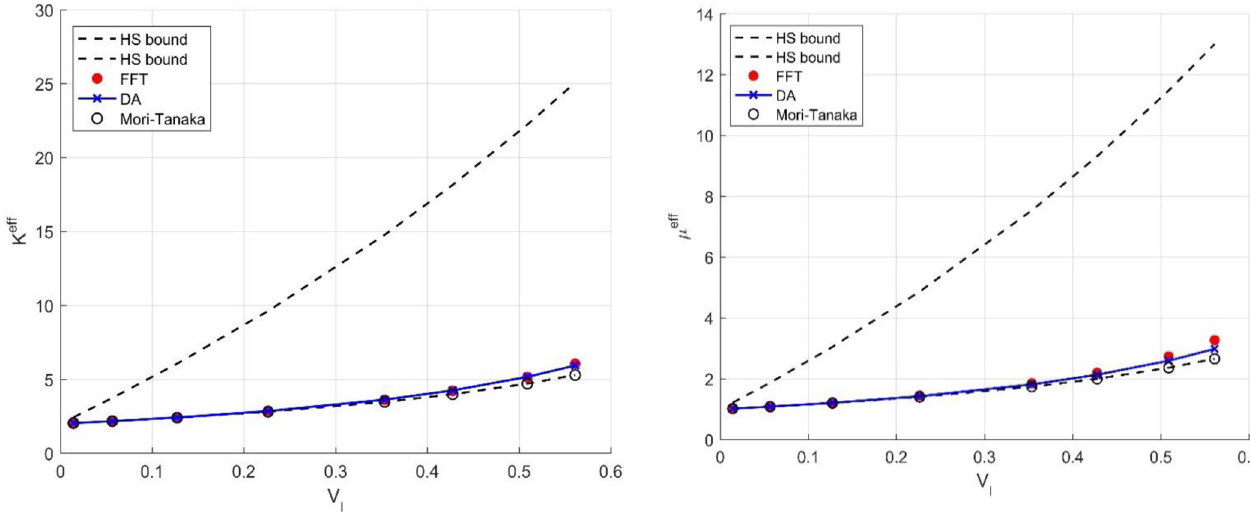
Fig. 2. Elastic bulk (left) and shear modulus (right) of three-phase composites with the case (A).